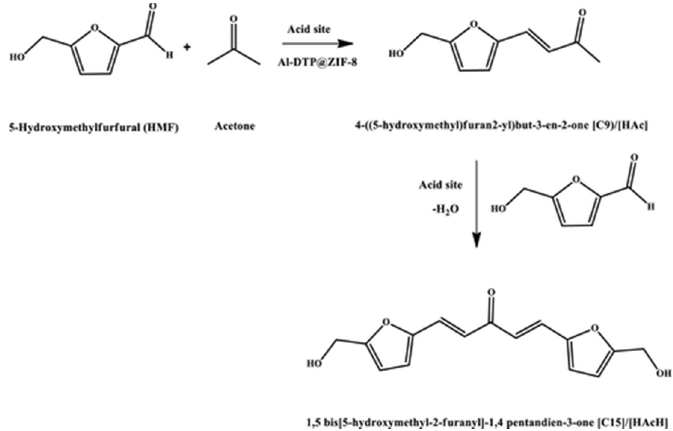
Figure 6. Aldol condensation of 5-hydroxymethylfurfural (HMF) with acetone over Al-DTP@ZIF-8. Reproduced with permission from [95]. Copyright (2019), American Chemical Society.